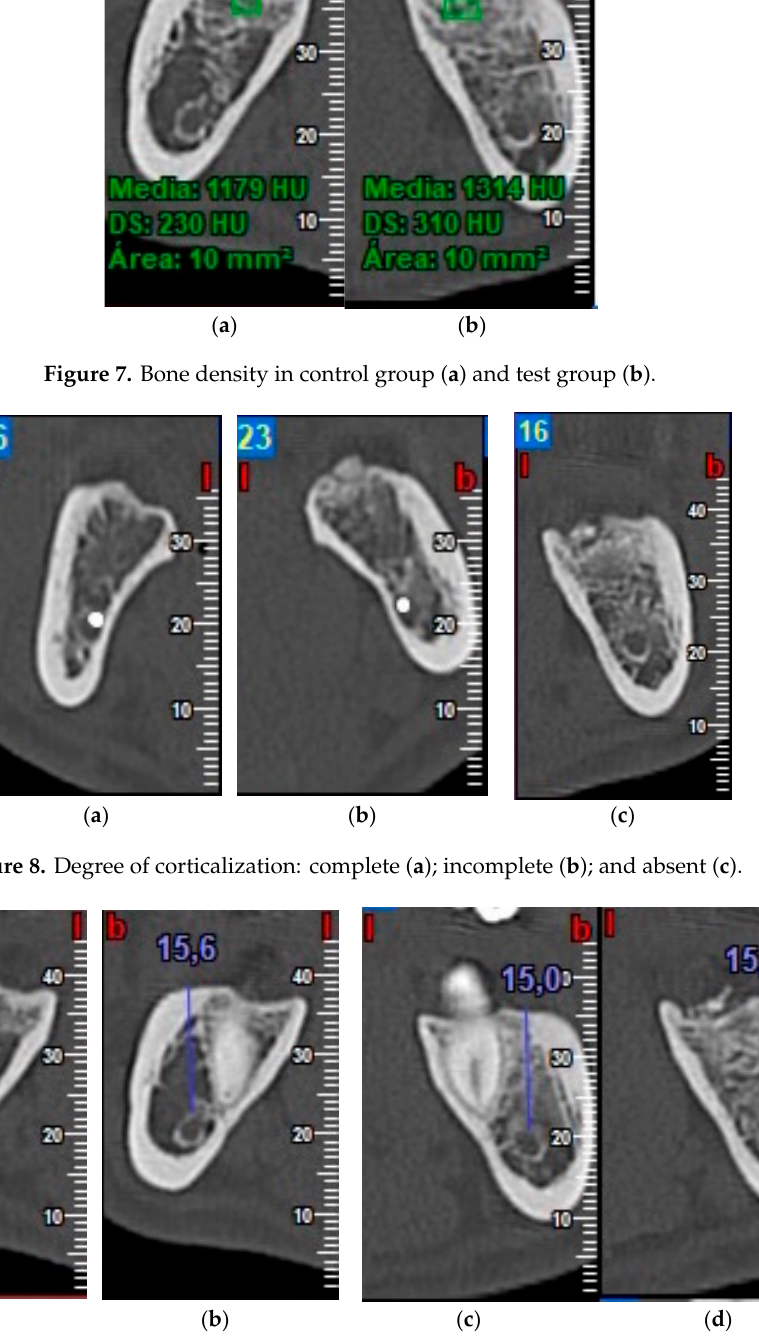
Figure 9. Distance from inferior alveolar nerve ( IAN) to bone crest on control side ( a,b ) and test side ( c,d ).